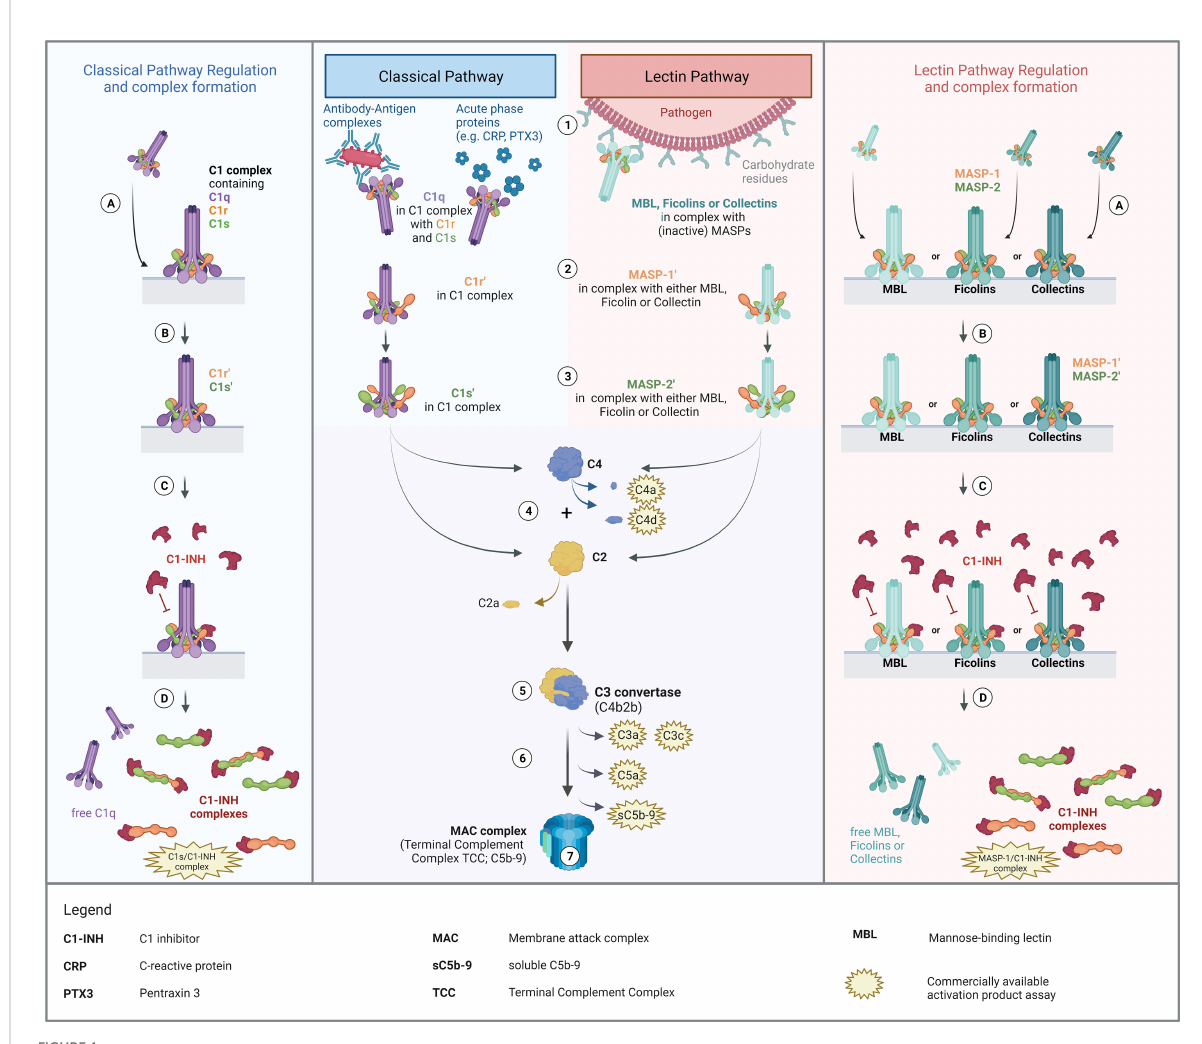
FIGURE 1 Overview of Classical and Lectin Pathway activation, regulation by C1-INH and proposed mechanism of complex formation. Middle panel: Activation of the classical and the lectin pathway (1). Recognition of triggering compound by the respective recognition molecules (C1q for classical pathway; MBL, fi colins or collectins for lectin pathway) and binding thereof to the activating compounds/structures. (2) Zymogen autoactivation of the fi rst serine protease after structural changes of the associated recognition molecules upon binding to activating structures. (3) Catalytically activation of the second serine proteases by the activated fi rst serine proteases. (4) Cleavage of C2 and C4 by activated serine proteases. (5) Formation of the classical C3 convertase, consisting of C4b and C2b [updated nomenclature according to (3)]. (6) Downstream complement activation going along with the release of several complement activation/split products. (7) Formation of the Terminal Complement Complex (TCC) or the Membrane Attack Complex (MAC complex), when formed on a membrane, and lysis or cell clearance. Left and right panel: Regulation of classical and lectin pathway activation by C1-INH and proposed theory of complex formation. (A) Binding of the pattern recognition molecule to an activating surface, resulting in conformational changes in the respective protein complexes. (B) Activation of serine proteases, allowing downstream complement activation. (C) Regulation of pathway activation by C1-INH through covalent binding to active sites of the serine proteases, blocking protease function and further activation of the respective pathways. (D) Dissociation of the complexes upon binding of C1-INH and release of C1-INH complexes as well as free pattern recognition molecules into the circulation. The fi gure was created with